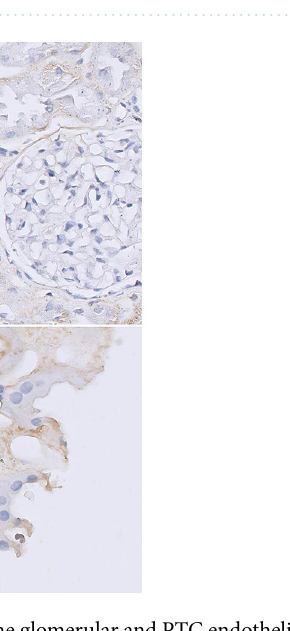
Figure 1. Examples of microthrombi in kidney biopsies immunohistochemically stained with and antibody against fibrin. ( a–c ) Microthrombus in peritubular capillary of reperfusion biopsy; ( d ) microthrombus in glomerular capillary in preimplantation biopsy.